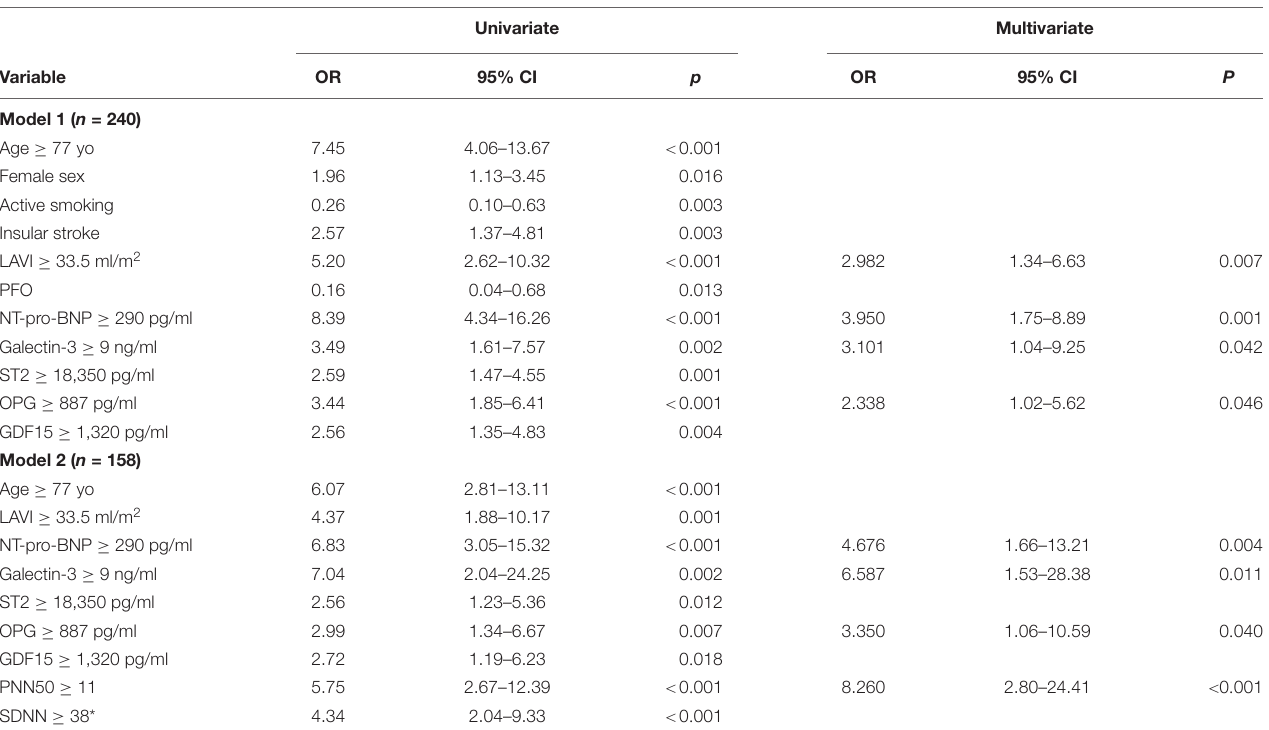
TABLE 4 | Univariate and multivariate analysis of AFDAS